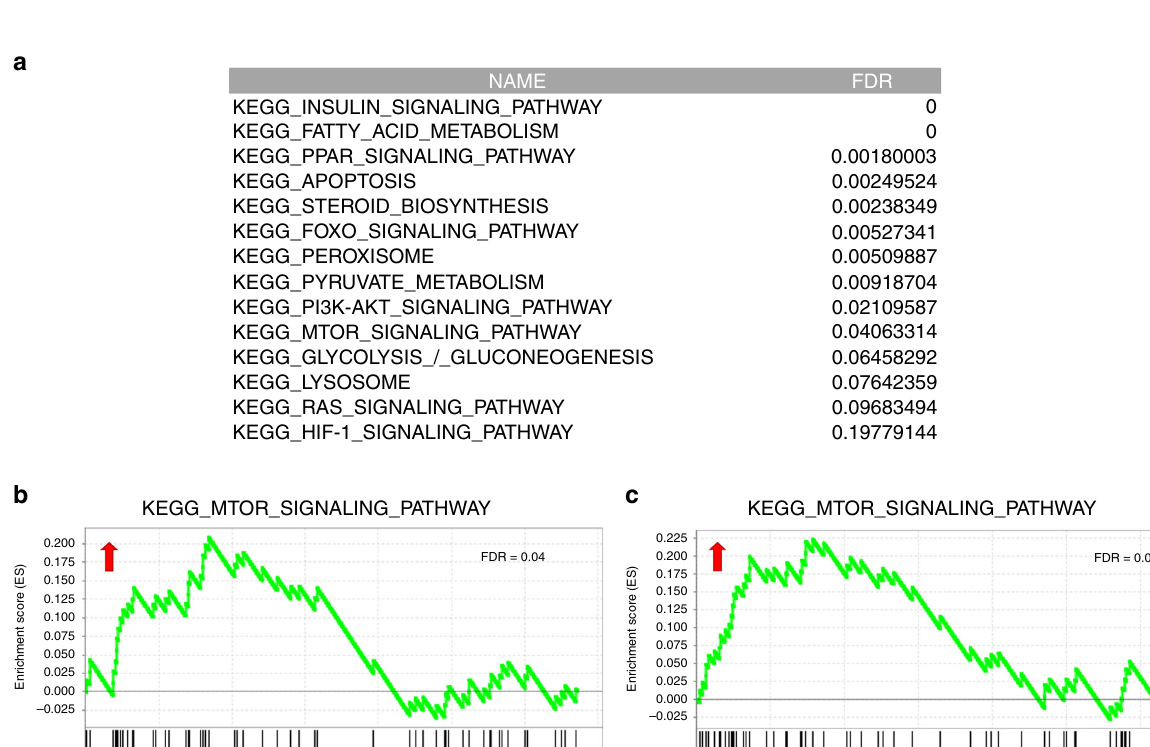
analysis (GSEA) of control fed G2 Terc − / − versus control fed Terc + / + con fi rmed that the mTOR pathway is upregulated in telomerase-de fi cient mice compared to wild-type mice (Fig. 5a; Supplementary Table 1), in agreement with higher hepatic levels